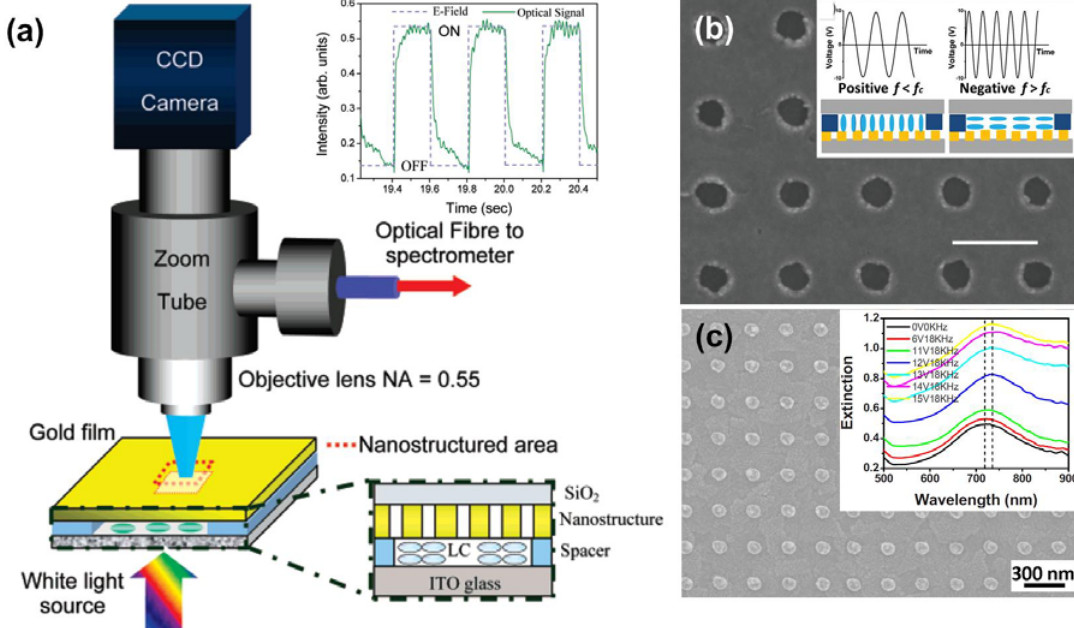
nanostructures and liquid crystals. Electric field is generated by applying voltages across the gold film and bottom ITO glass, switching effect at the wavelength of 670 nm is shown in the inset; ( b ) SEM image of nanohole array and the working mechanism of DFLC. The scale bar indicates one period length of 300 nm; ( c ) SEM image of gold nanorods of another design of plasmonic switch using DFLC. The inset extinction spectrum shows the plasmonic resonance change under different voltage and frequency